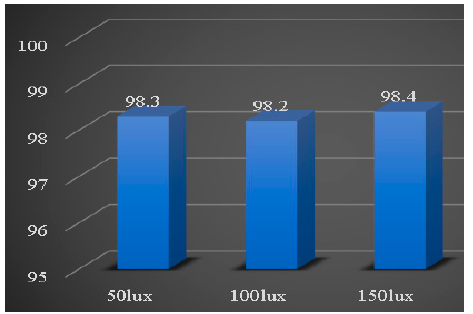
Figure 13. Graph of the experiment result for foot recognition. Table 3. Result for foot recognition experiment—Kruskal–Wallis Test.